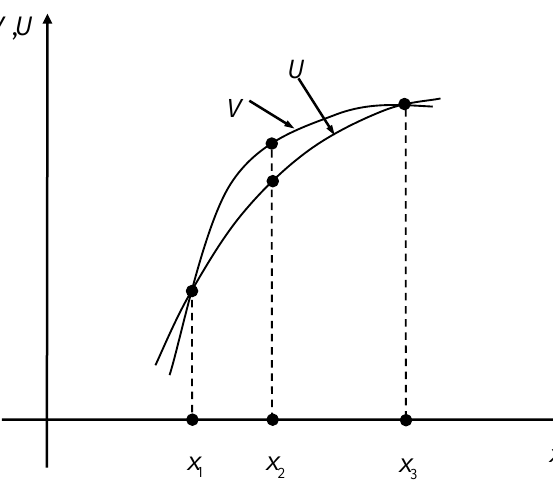
Figure 1. Illustration of “More Risk-Aversion”.